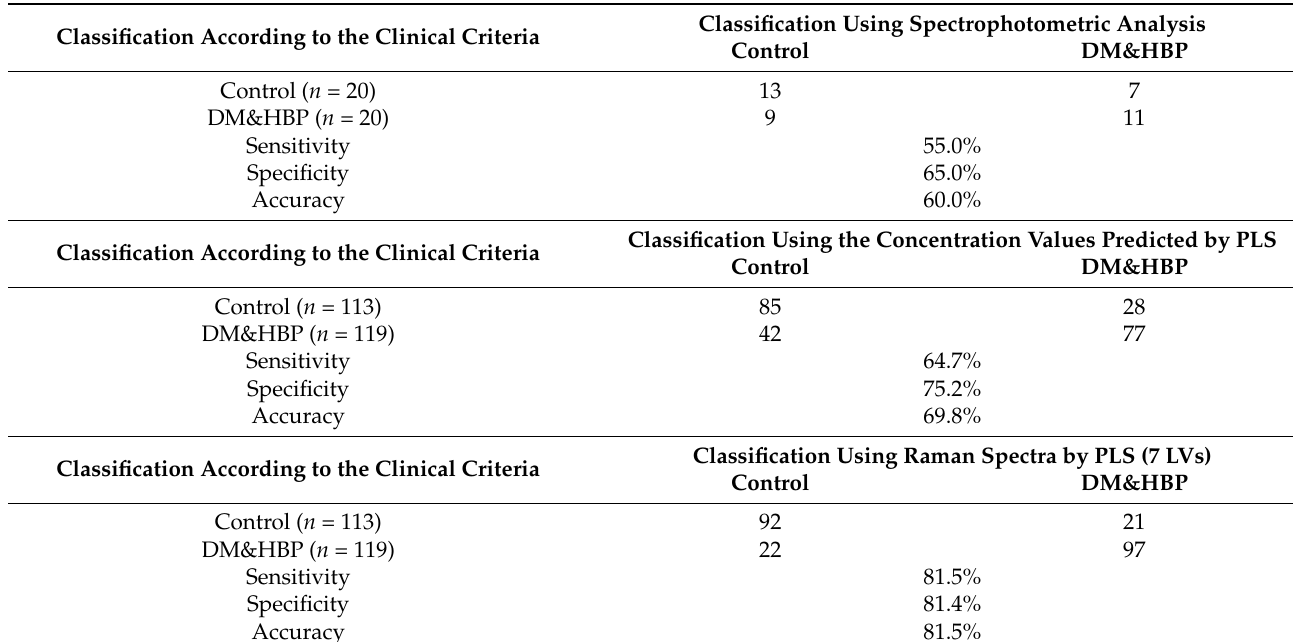
Table 2. Confusion table with the results of the discriminant models used to classify subjects into CT and DM&HBP groups using LDA applied to the concentrations of the biomarkers obtained by spectrophotometric analysis and concentrations predicted by PLS regression. The classification by PLS-DA using the entire Raman spectra dataset is also